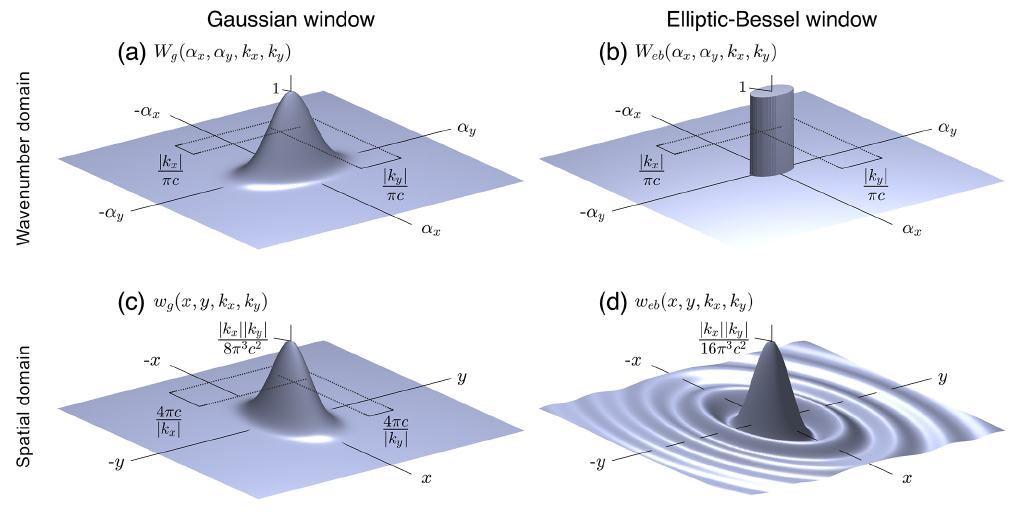
Figure 3. Illustrative surface plots of the wavenumber-domain (top row) and spatial-domain (bottom row) forms of the traditional Gaus- sian (a, c) and new Elliptic–Bessel (b, d) windowing functions used in the two-dimensional Stockwell transform for arbitrary wavenumbers k x and k y and scaling parameter c . The semi-major and semi-minor axes of the Elliptic–Bessel window in (b) are equal to the correspond- ing standard deviations of the Gaussian window in (a) , where both windows have a central value equal to unity. In the spatial domain, the Elliptic–Bessel window in (d) has a central value equal to half that of the Gaussian window in (c) , both of which have spatial integrals equal to unity. For details, see